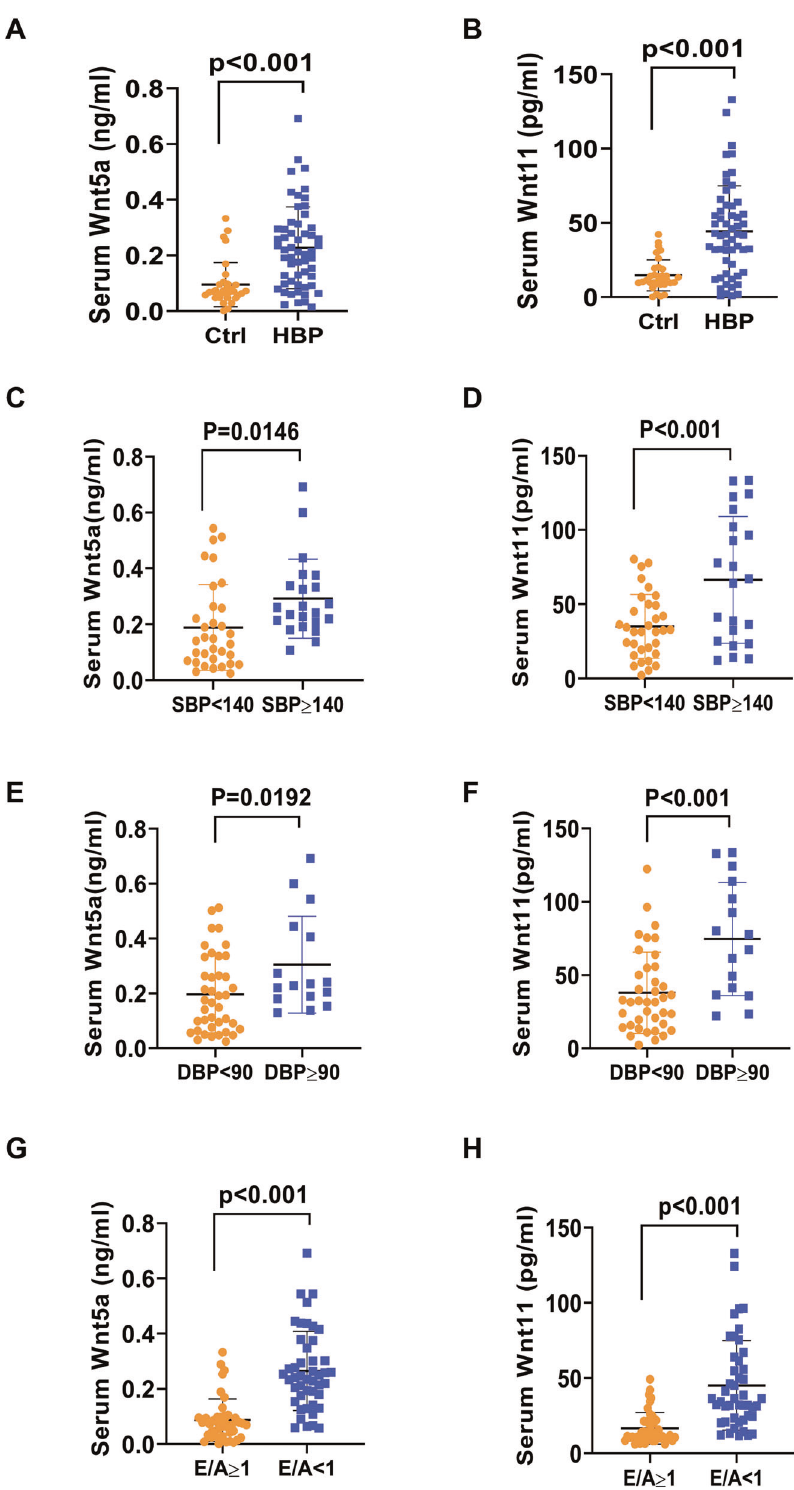
Fig. 1 The levels of Wnt5a and Wnt11 are increased in the serum of patients with hypertension. The level of serum Wnt5a or Wnt11 was measured by ELISA analysis. A , B The level of serum Wnt5a or Wnt11 in hypertension group (HBP, n = 56) and control group (Ctrl, n = 33); C , D The level of serum Wnt5a or Wnt11 in SBP ≥ 140 mmhg group ( n = 22) and SBP < 140 mmhg group ( n = 34); E , F The level of serum Wnt5a or Wnt11 in DBP ≥ 90 mmhg group ( n = 16) and DBP < 90 mmhg group (DBP, n = 40); G , H The E/A ratio between the healthy control group (Ctrl) and the hypertension (HBP) group was detected by echocardiography, and the ratio was divided into E/A ≥ 1 ( n = 43) and E/A < 1 ( n = 46). The level of serum Wnt5a or Wnt11 in the two groups were analyzed. SBP systolic blood pressure, DBP diastolic blood pressure. All data were expressed as means ±